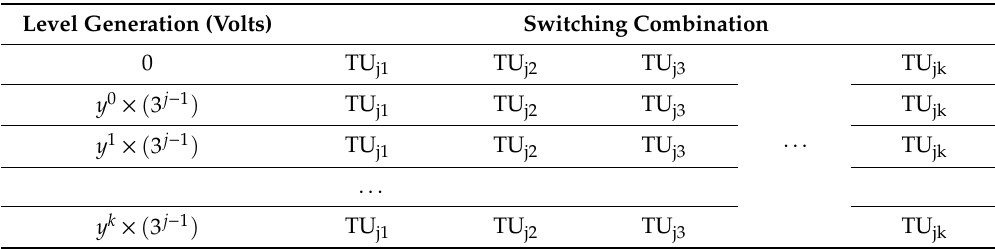
Table 1. Switching combination for the k-state